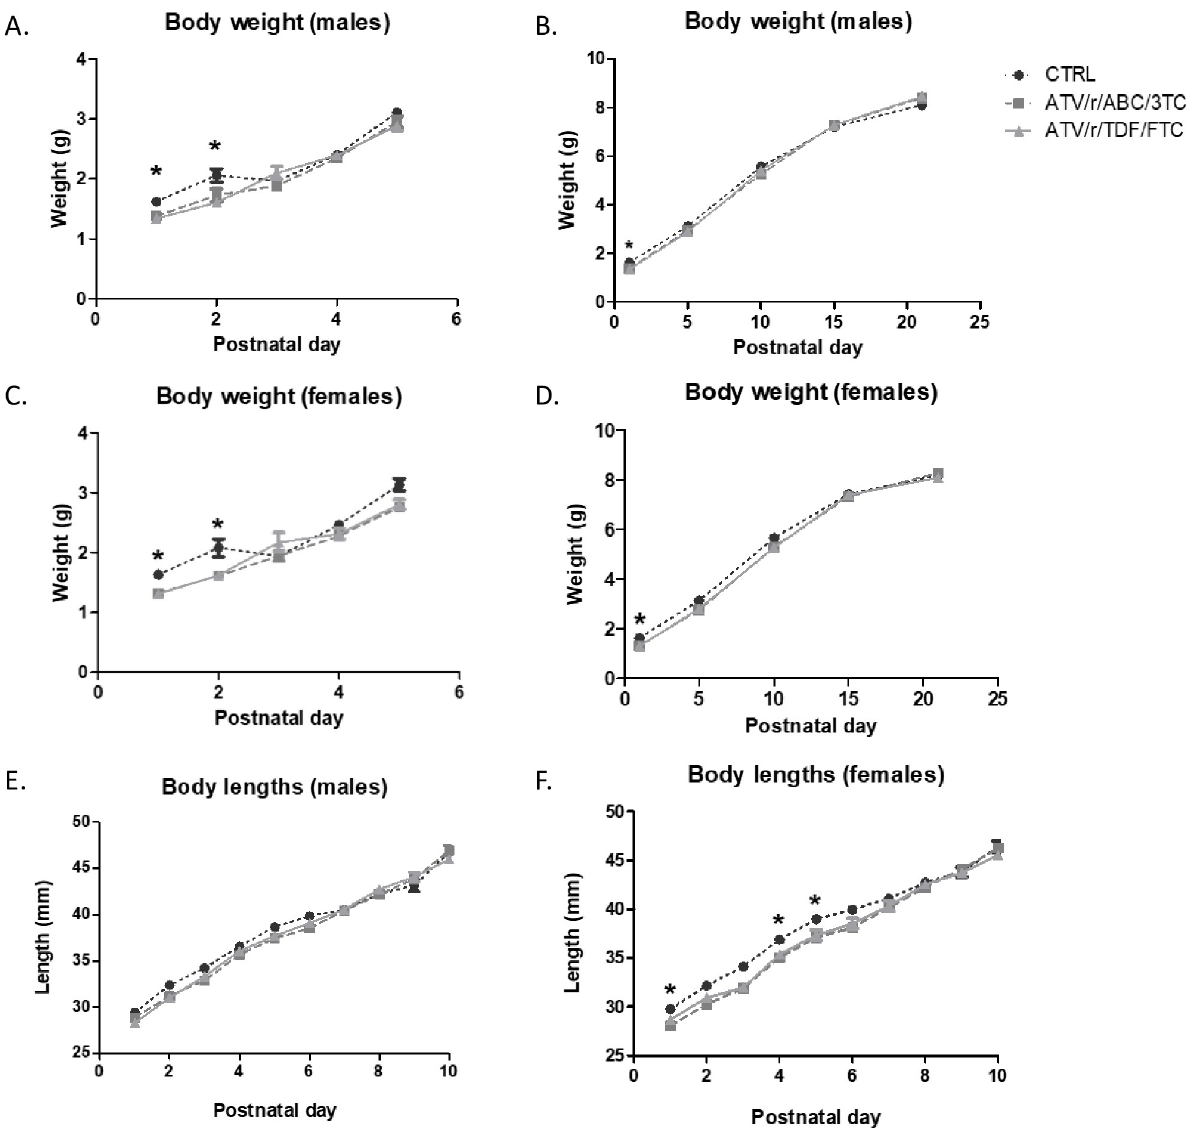
Fig 2. Pups exposed in-utero to ART are born small and weigh less for gestational age. Pup weight and length were assessed daily from postnatal day 1–21. Weight for the first 5 day is shown in (A) for males and (C) for females. Weight for the entire course is shown in (B) for males and (D) for females. Length is shown in (E) for males and (F) for females. Data are mean ± SEM (n = 11–34 pups/group). A mixed effects model was used to examine differences at each day between control and treatment arms (fixed effect) accounting for litter effects (random effect). � p < 0.05 vs. control. ATV/r, ritonavir-boosted atazanavir; ABC, abacavir; 3TC, lamivudine; TDF, tenofovir; FTC, emtricitabine; CTRL, control. geotaxis and cliff-aversion reflexes in male and female pups (Fig 4A and 4B). Mature responses are expected in these tests normally by P4 and P5 respectively [20, 23], as seen in our control group. In most U-ART pups, mature responses were not observed before P6. In utero exposure to ATV/r/ABC/3TC delayed emergence of negative-geotaxis in male pups approximately by 2 days (p = 0.01) and in females by 2.5 days (p = 0.001) (Fig 4A). Similarly, exposure to ATV/r/ TDF/FTC delayed the appearance of negative-geotaxis in male pups approximately by 2 days (p = 0.008) and in females by 2.5 days (p = 0.001) (Fig 4A). In utero exposure to ATV/r/ABC/ 3TC delayed emergence of cliff-aversion in males (p = 0.012) and females (p = 0.004)